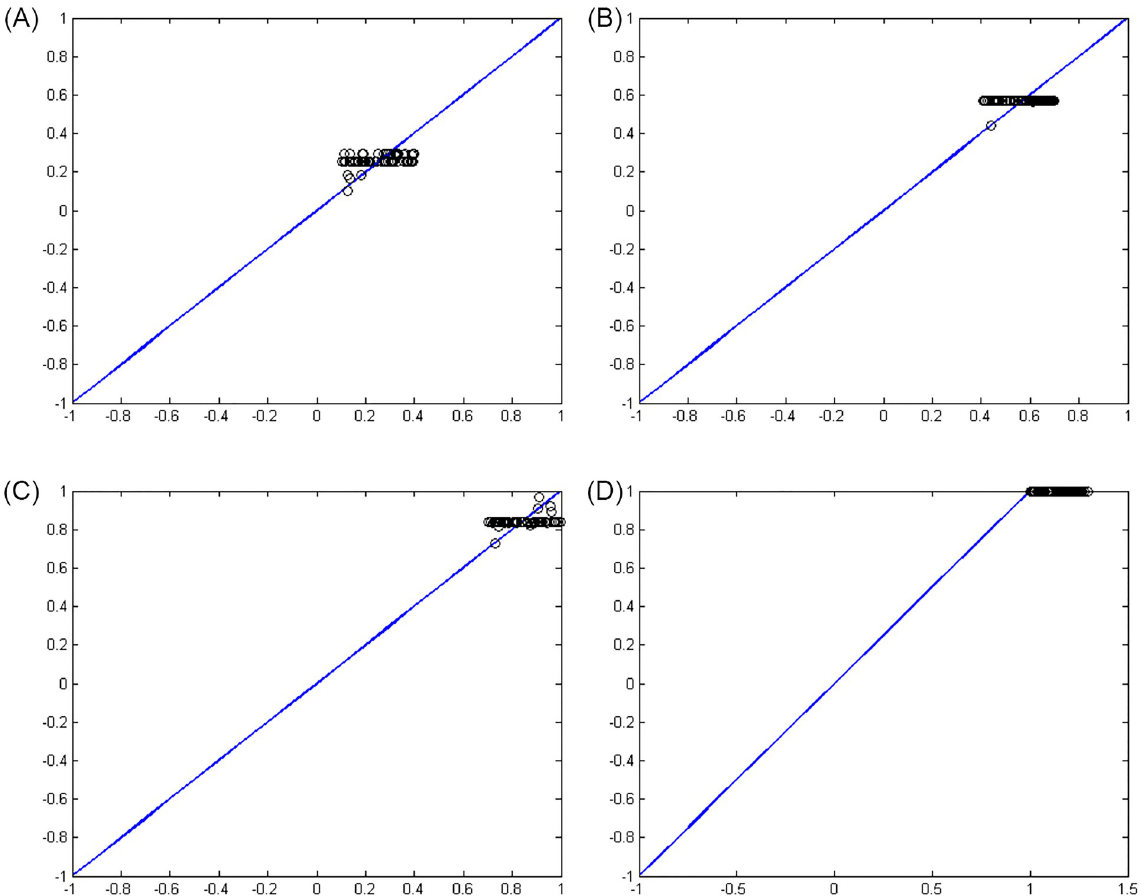
Fig 8. The distance between the real answers and the regression line (regression function) obtained with ANN-PSO in the training samples: (Fig 8A)[0.1, 0.4], (Fig 8B)[0.4, 0.7], (Fig 8C)[0.7, 1] and (Fig 8D)[1, 1.3] range.